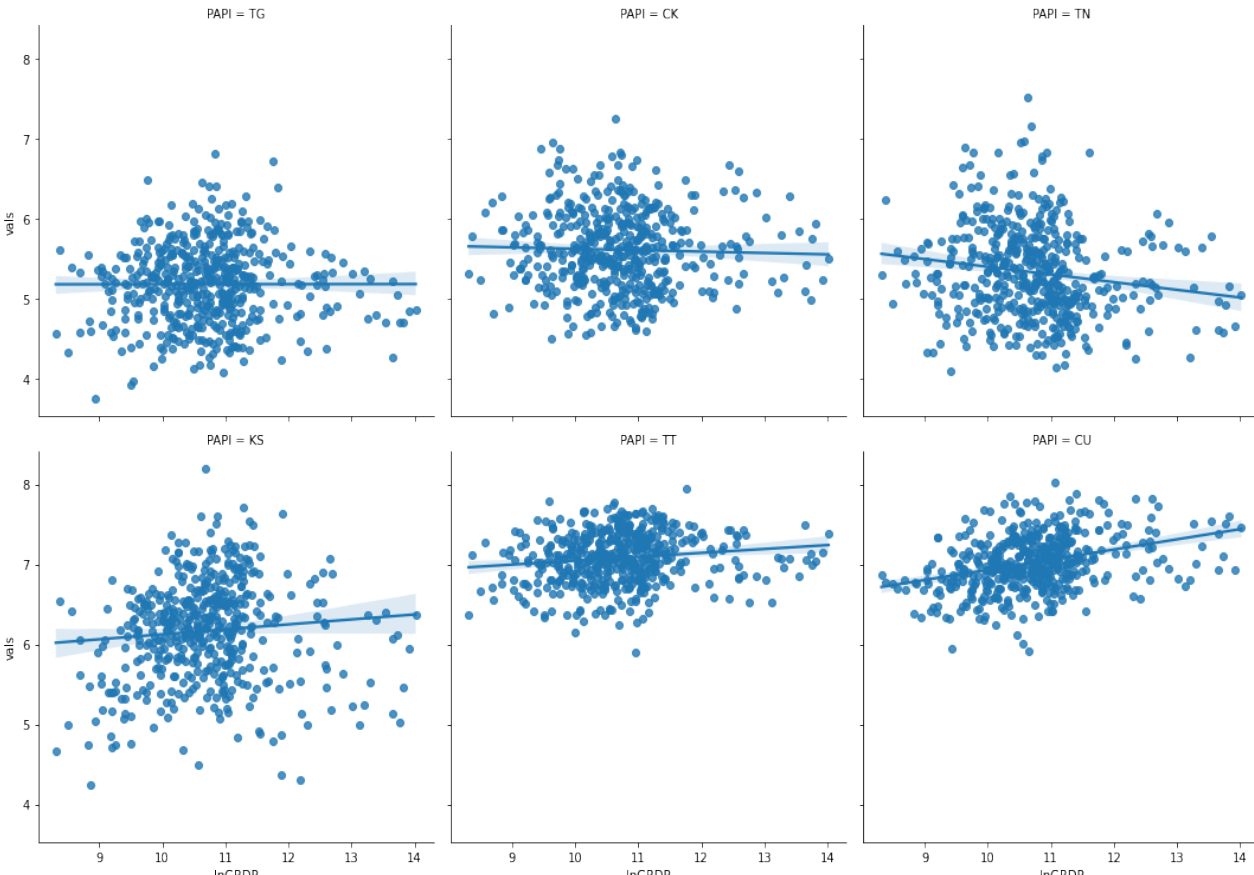
Figure 3. The relationship between the quality of public administration and the gross regional domestic product.